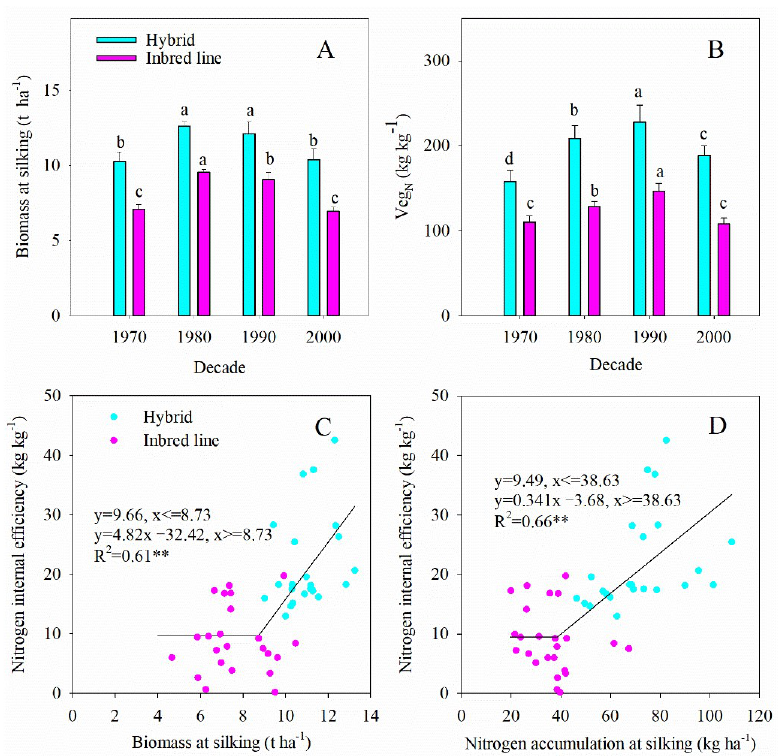
Figure 4. Relationship of BM silk, Veg N and NIE of maize hybrids and inbred lines in different decades. Note: ( A ), biomass at silking; ( B ), Veg N ; ( C ), Relationship of BM silk and NIE; ( D ), Relationship of Veg N and NIE. ** indicate significant differences at 0.01 probability. Different letters in the same nitrogen treatment indicate significant differences at 0.05